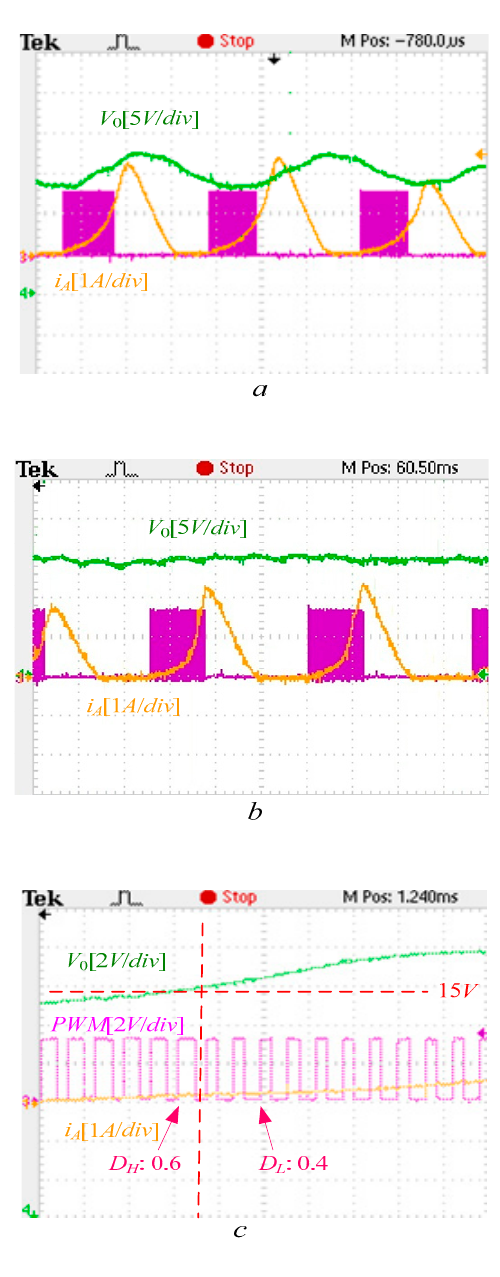
Figure 13. The experiment waveforms of SRG. ( a ) Experiment waveforms of output voltage V 0 under PWM control; ( b ) experiment waveforms of output voltage V 0 under PT control; ( c ) the details of experiment waveforms under PT control.